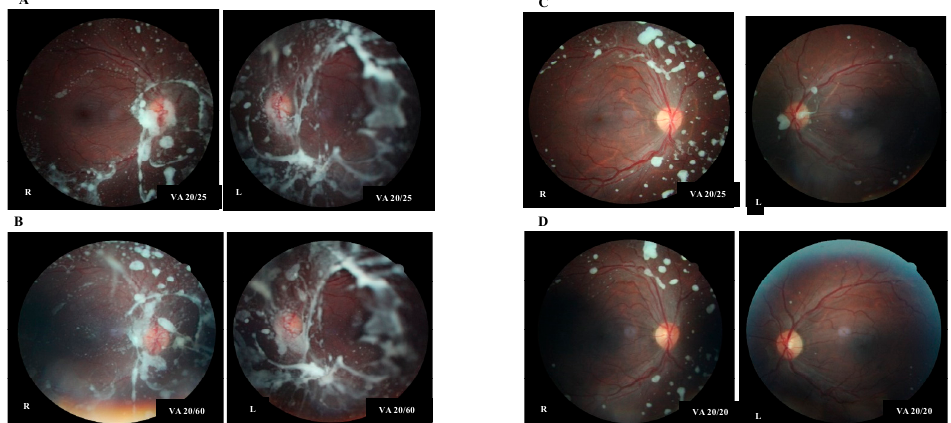
Figure 1. Preoperative fundus photographs showing progression of the deposits and decreasing visual acuity in the right (R) and left (L) eyes ( A and B ). Postoperative fundus photographs showing reduction in deposits in both eyes ( C ) and improvement in visual acuity ( D ).